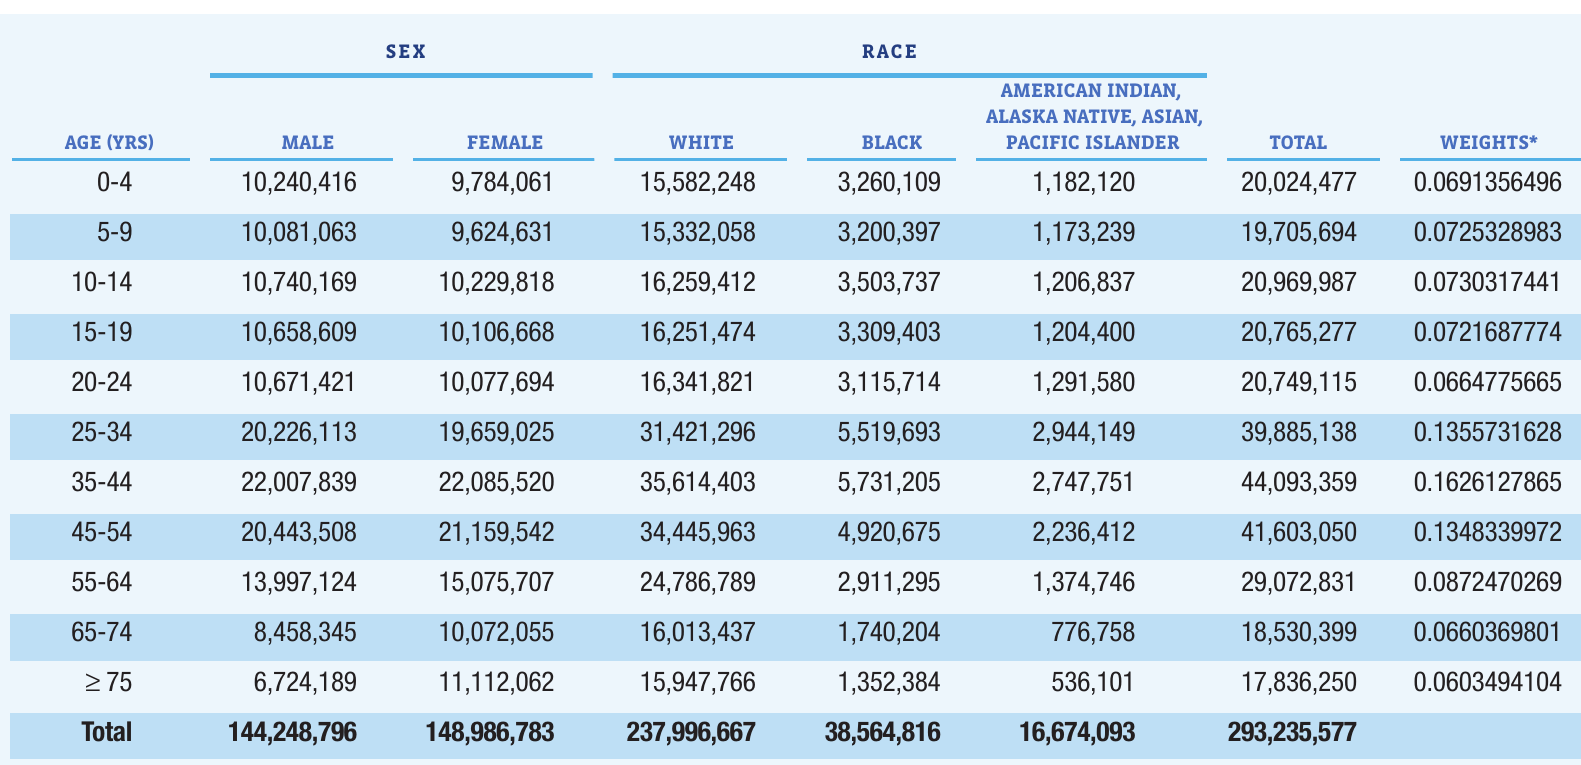
TABLE 21: Estimated Average Annual 2002–2006 Population by Age Group, Sex, and Race; Weights for 2000 Standard Population by Age